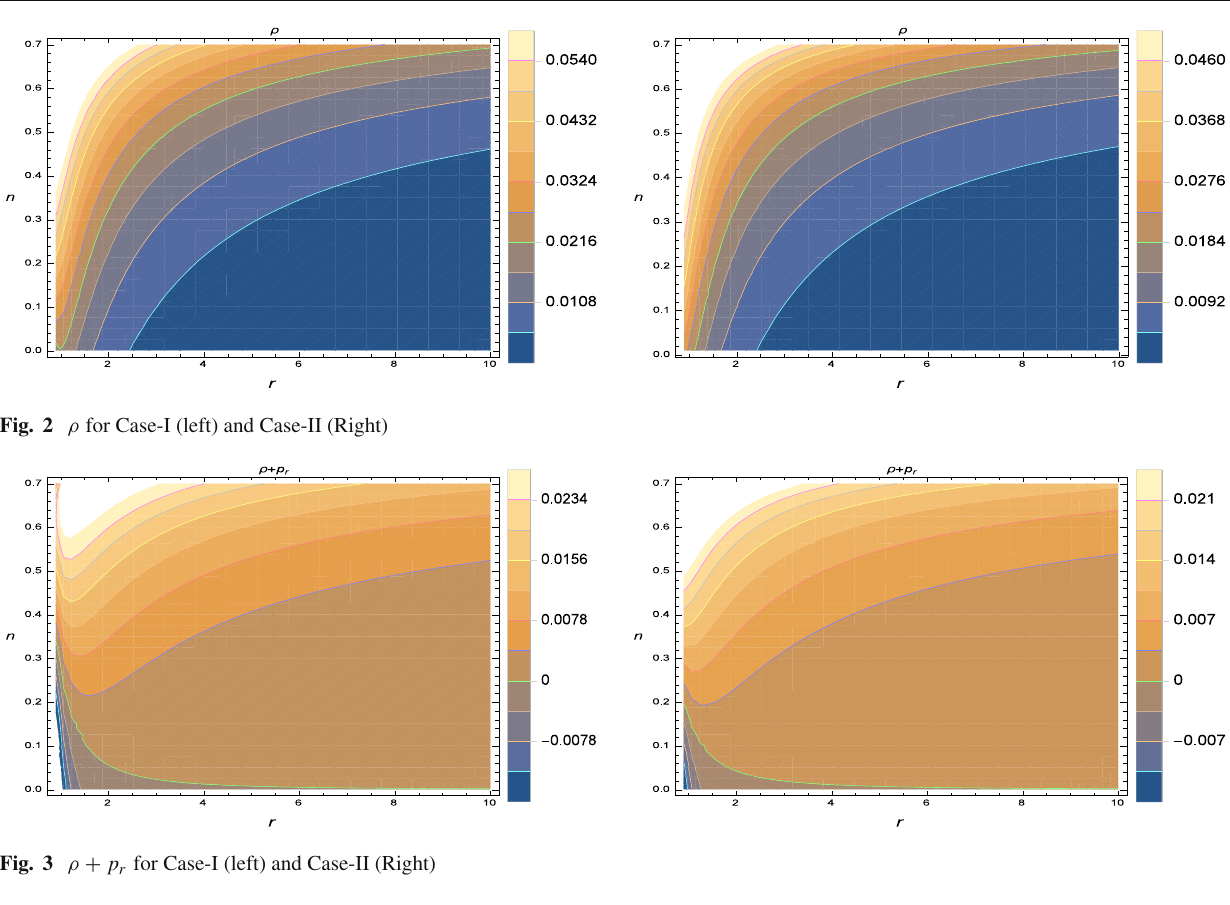
Fig. 3 ρ + p r for Case-I (left) and Case-II